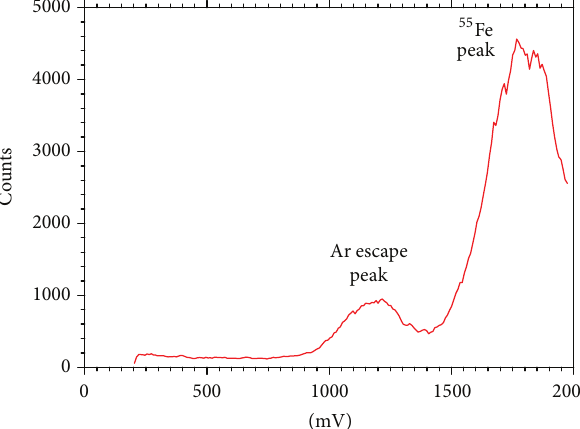
Figure 6: The energy spectrum from 55 Fe calibration